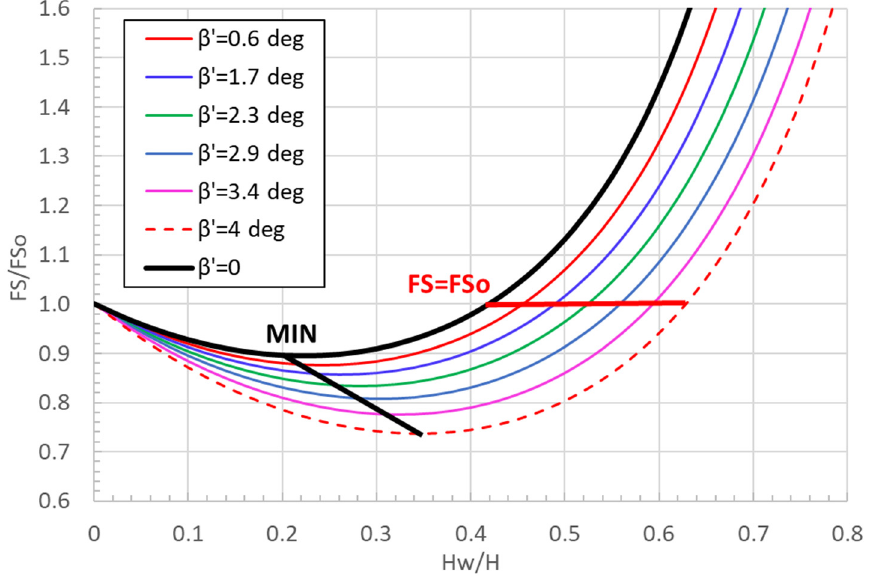
Figure 10. Variation of the safety factor (FS) against overall slope instability with water depth (H w ) in the lake. The safety factor (FS) is normalized with the safety factor (FS o ) of the same slope when H w = 0. H is the height of the slope and β ’ is the slope of the base of the failure surface.